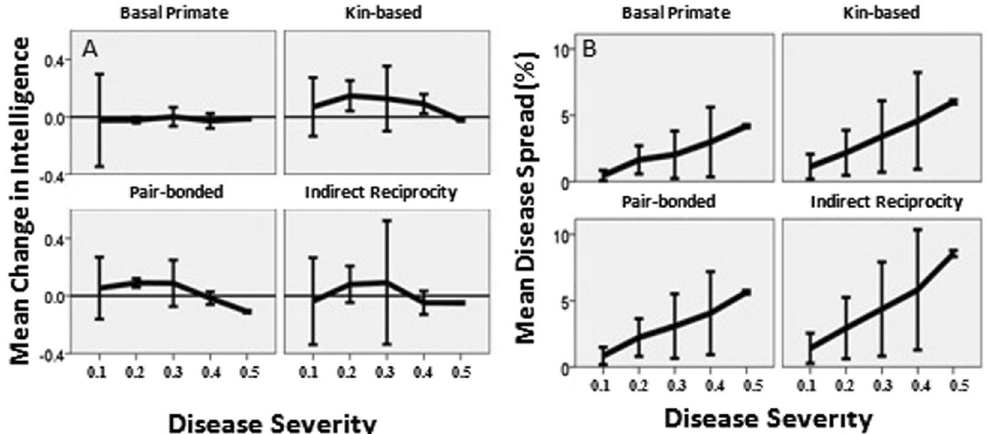
Figure 3. Net change in intelligence (A) and disease spread (B) in each of the four social systems in response to diseases with severities ranging from 0.1 to 0.5. The basal primate social system produces very little change in intelligence. A: While the pair-bonded, indirect reciprocity, and kin-based systems each produced increases in intelligence at disease severities of 0.3 or below, only the kin-based system increased intelligence in response to diseases with severities of 0.4. B: The highly overlapping confidence intervals indicate that levels of disease spread are similar across social systems under the Effective Care Model. In both graphs, the error bars are 95% confidence intervals. The graph pools across community sizes and initial